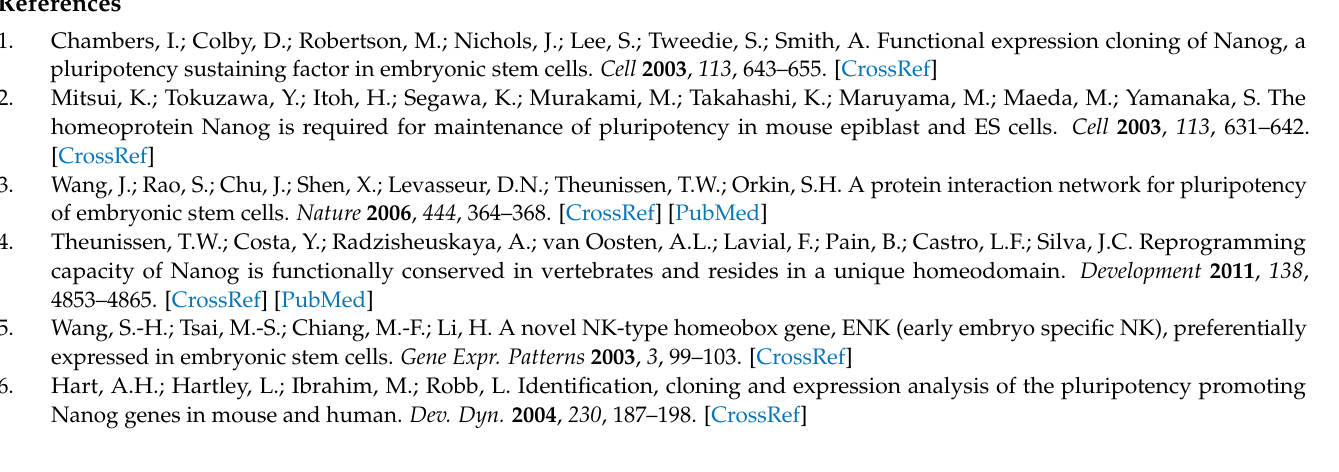
Figure S4: The promoter sequence of PsNanog gene; Figure S5: Fluorescence immunostaining detected the specificity and accuracy of aPsNanog; Table S1: Sequences of primers used in this